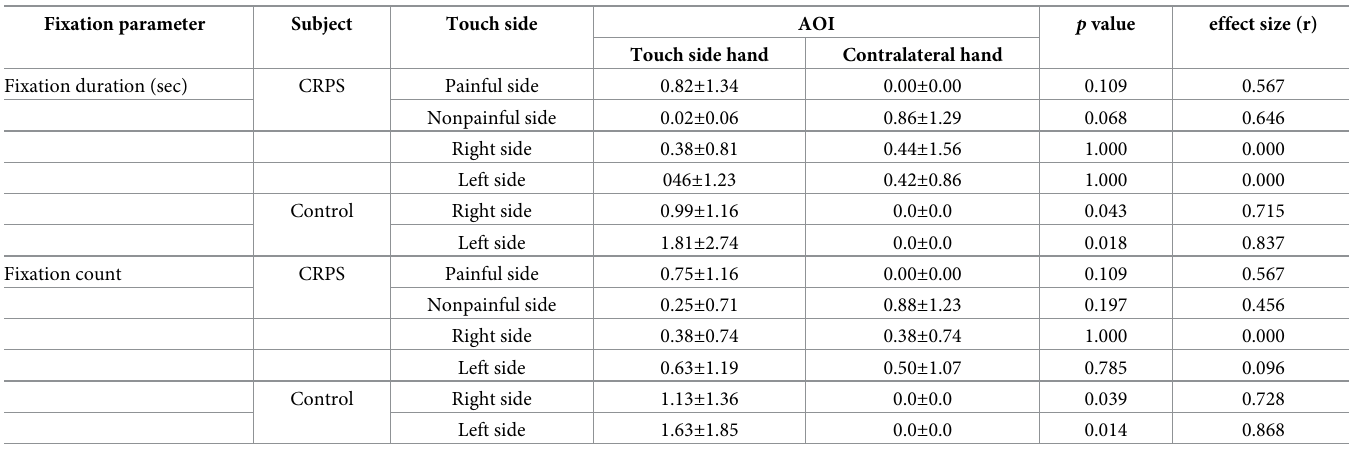
Table 3. Eye movement data of video clip